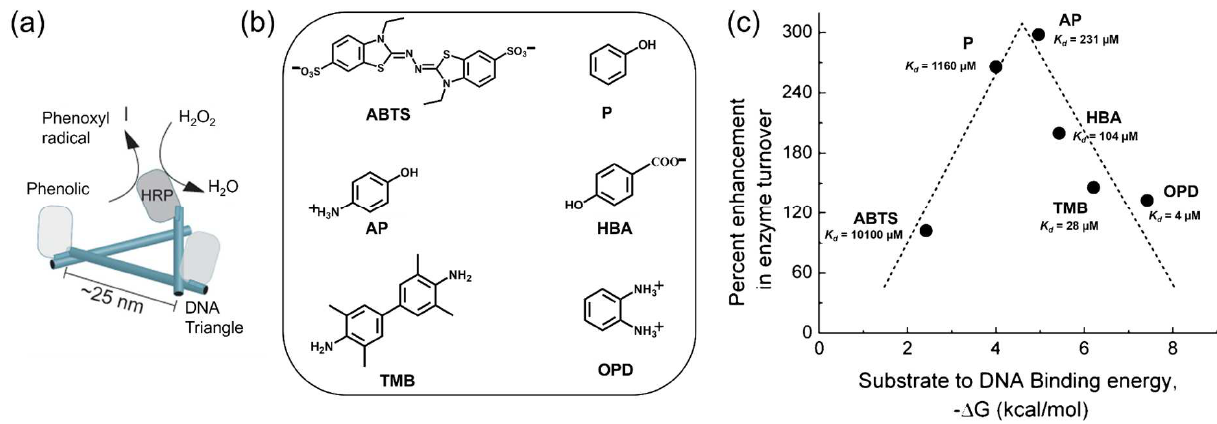
Figure 5. Horseradish peroxidase (HRP) was assembled on the DNA triangle with the study of substrate affinity to the scaffold [73]. ( a ) A scheme representing the assembly of HRP on the triangular DNA scaffold. ( b ) The structures of HRP substrates. 2,2′-azino-bis(3-ethylbenzothiazoline-6-sulphonic acid) (ABTS), phenol (P), p -Aminophenol (AP), p -hydroxybenzoic acid (HBA), 3,3′,5,5′-tetramethylbenzidine (TMB), o -phenylenediamine (OPD) were used in this study. ( c ) The enhancement of HRP activity on the DNA scaffold as a function of the predicted substrate–DNA binding energy. Reprinted with permission from Ref. [73]. Copyright 2013 American Chemical Society.